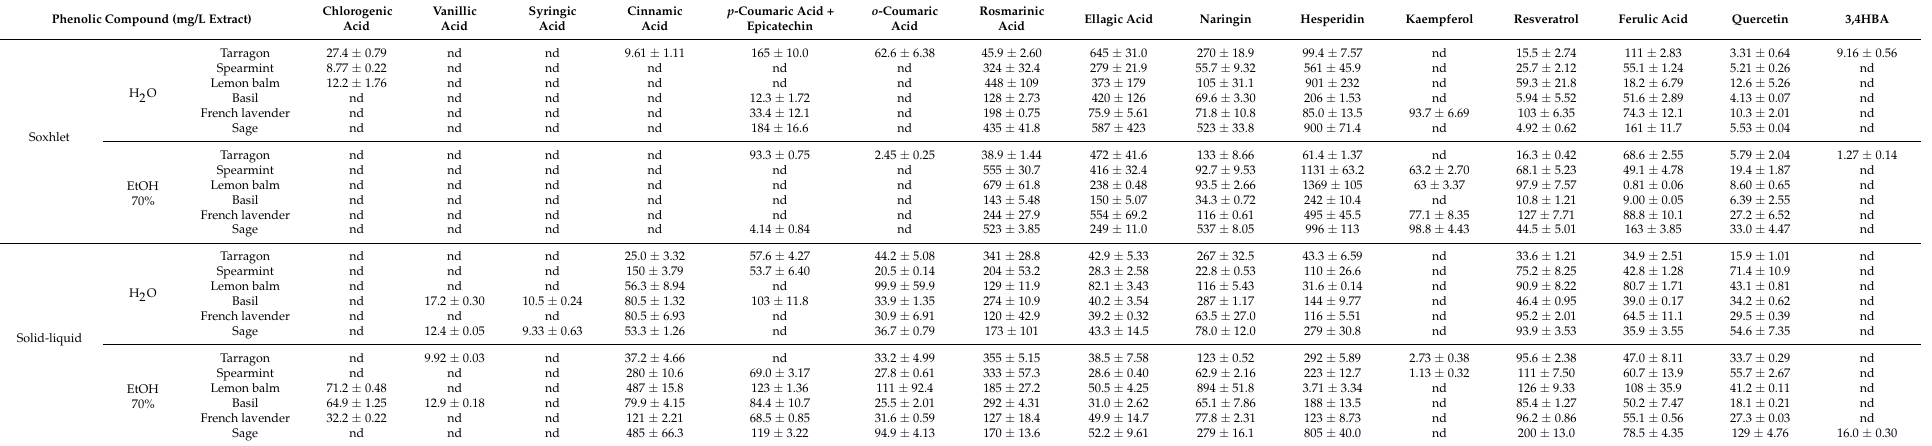
Table 2. Identification and quantification of phenolic compounds present in the extracts